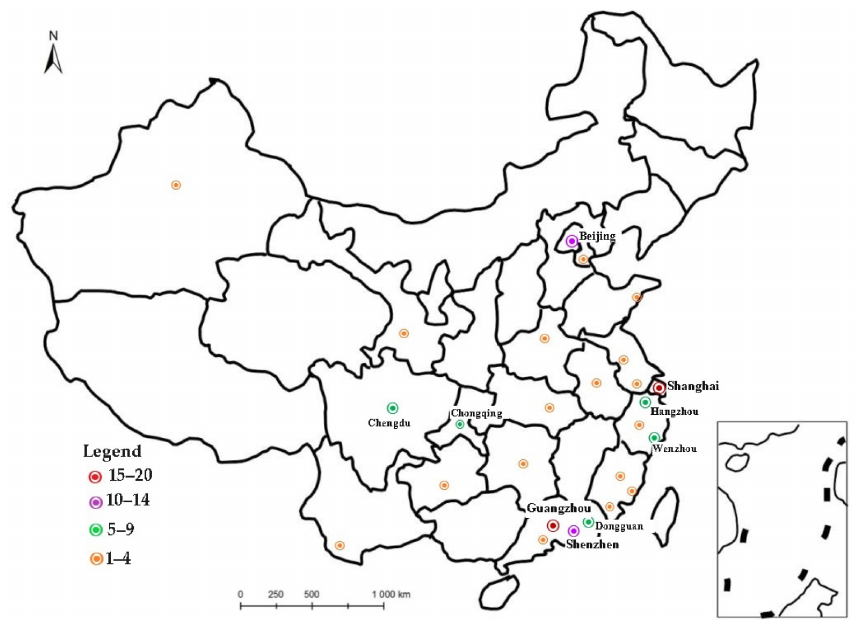
Figure 3. Distribution of the articles by city.